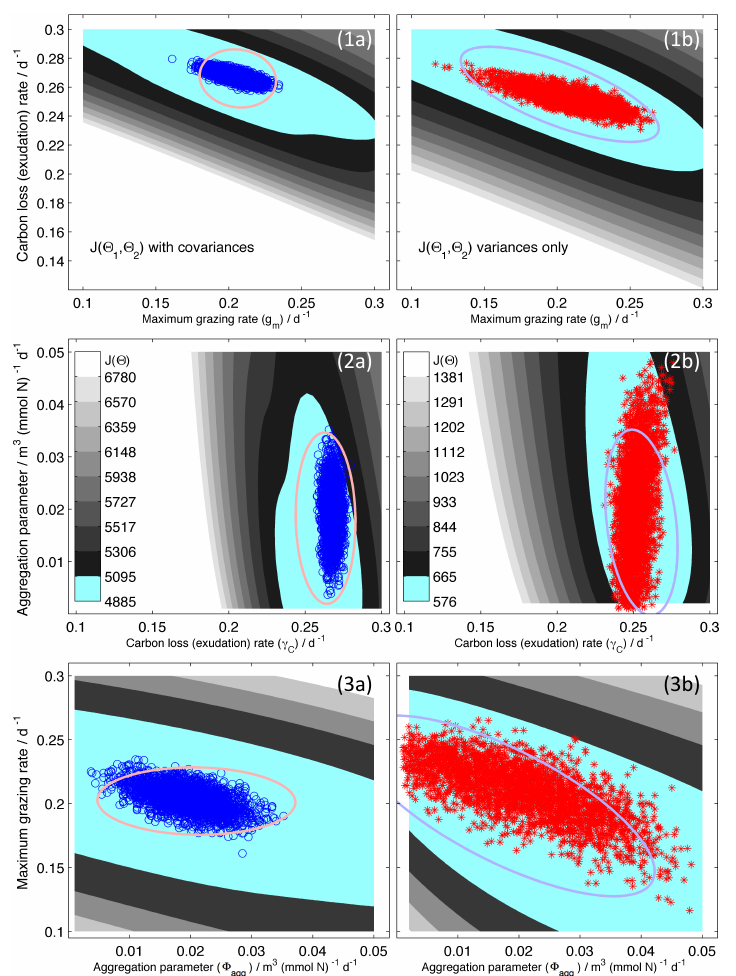
Figure 2. Cost function contours when varying values of a combination of two parameters J( b (cid:50) m ± (cid:49) m , b (cid:50) n ± (cid:49) n ) around the optimum estimate at ( b (cid:50) m , b (cid:50) n , min( J )), while values of all other parameters remain fixed. Each plot resolves a pairwise combination out of three parameters that all specify phytoplankton biomass losses. The two columns reveal differences in error margins due to different cost functions with same data for the same model: (a) with covariances explicitly regarded and (b) all data are assumed to be independent. First row ( 1a and 1b ): combination of maximum grazing rate ( (cid:50) 1 = g m ) and carbon exudation rate ( (cid:50) 2 = γ C ). Second row ( 2a and 2b ): combination of the aggregation parameter ( (cid:50) 3 = (cid:56) agg ) and γ C . Third row ( 3a and 3b ): combination of g m and (cid:56) agg . Markers show credible regions of parameter estimates obtained with Markov chain Monte Carlo (MCMC) method (dots for J with covariances, asterisks for J with variances only). Error ellipses (lines) depict point-wise 95% confidence regions derived from an approximated and inverted Hessian matrix, according Eq. (22). The cyan coloured region embeds all cost function values that are lower than an upper threshold (cid:49)J ∗ (α = 0.05), derived from a distribution of J( b (cid:50) ) − J ∗ ( b (cid:50) ) , where J ∗ ( b (cid:50) ) are cost function values at b (cid:50) using resampled data (Fig. B1 in